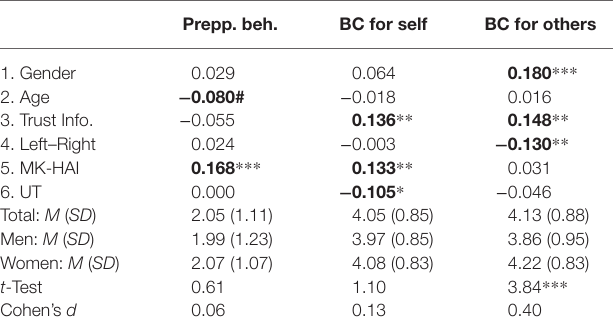
TABLE 4 | Means, SDs, and correlations for gender, age, trust in official information, political orientation, health anxiety and uncertainty tolerance with self-centered prepping behavior, behavior change to avoid infection and behavior change in order to not infect others in Study 2. Prepp.